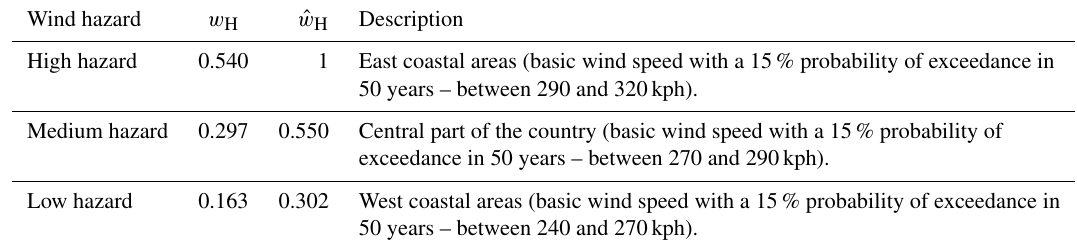
Table 6. Wind hazard parameters.